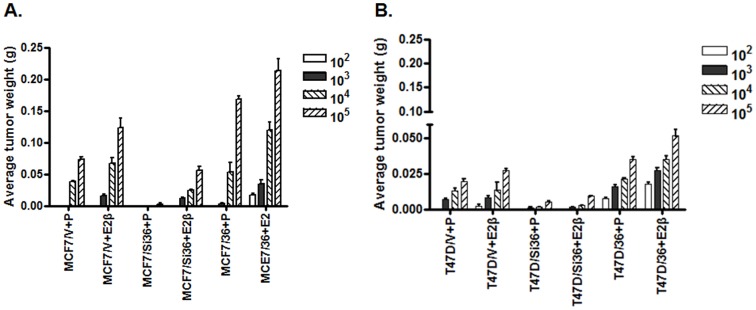
ER-α36-mediated estrogen signaling enhances the tumor-seeding efficiency of ER-positive breast cancer stem/progenitor cells.Different variants of MCF7 and T47D cells at limited dilutions were implanted in the mammary fatpad of the ovariectomized female mice supplemented with estrogen or placebo pellets. The tumor-seeding efficiency was examined by measurement of tumor weight. The data represent the mean ± SE observed in six mice in each group.